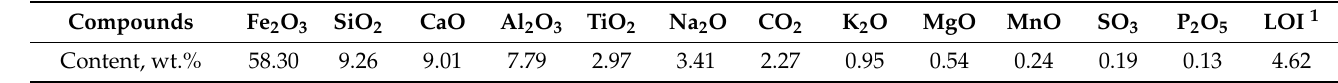
Table 2. Chemical composition of the